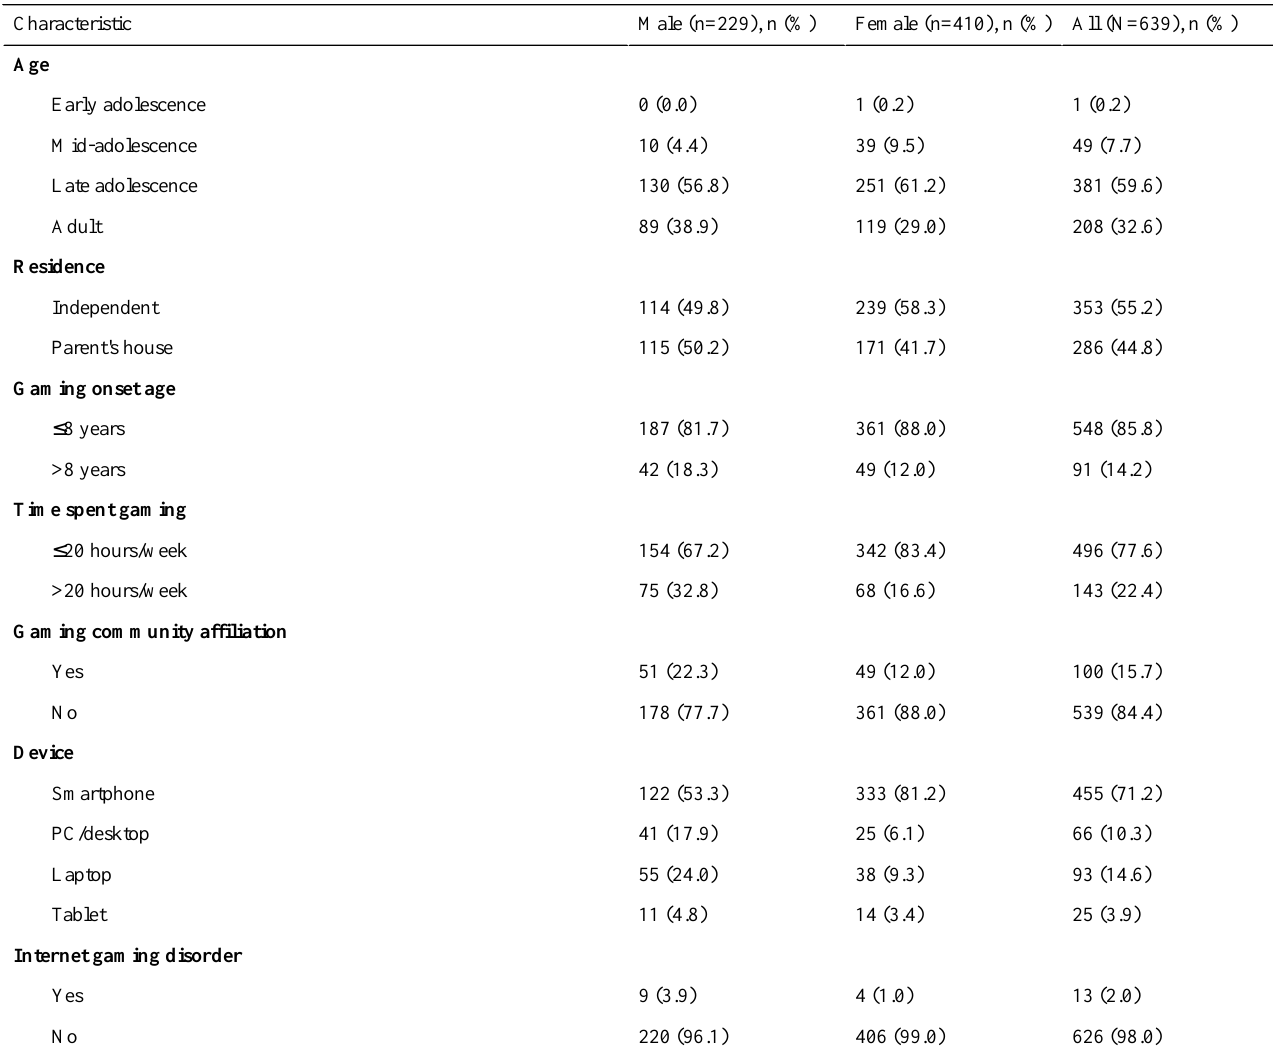
Table 1. Respondent